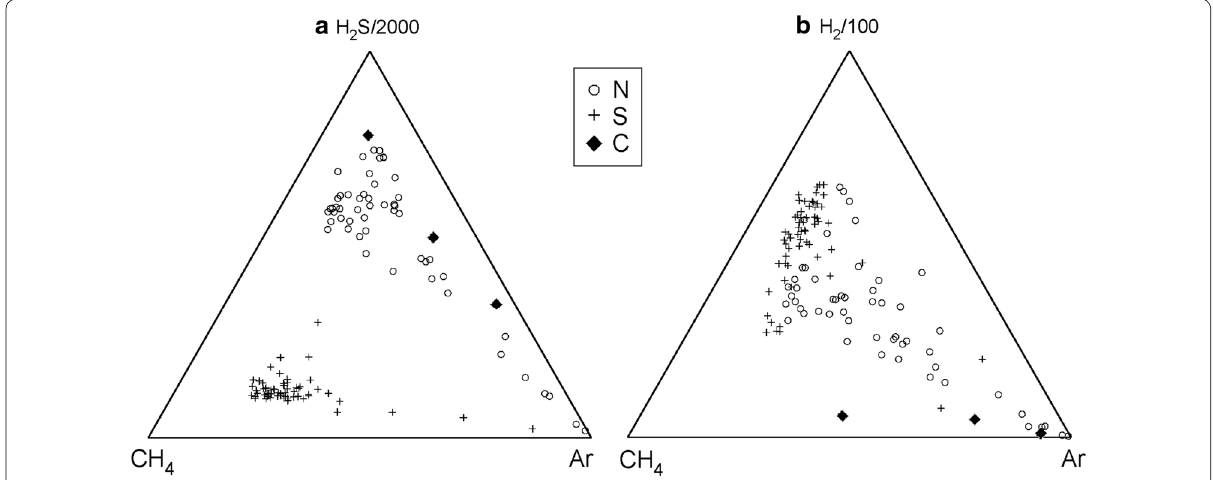
Fig. 8 Triangular diagrams for CH 4 –H 2 S–Ar ( a ) and CH 4 –H 2 –Ar ( b ) ternary